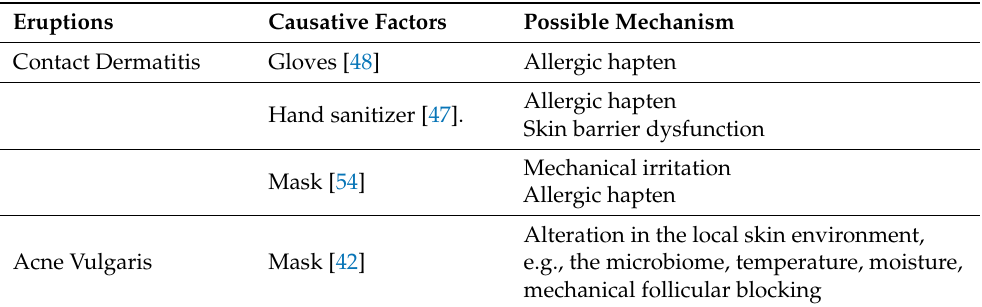
Table 1. Summary of dermatosis associated with COVID-19-engaged work. Eruptions Causative Factors Possible Mechanism Contact Dermatitis Gloves [48] Allergic hapten Hand sanitizer